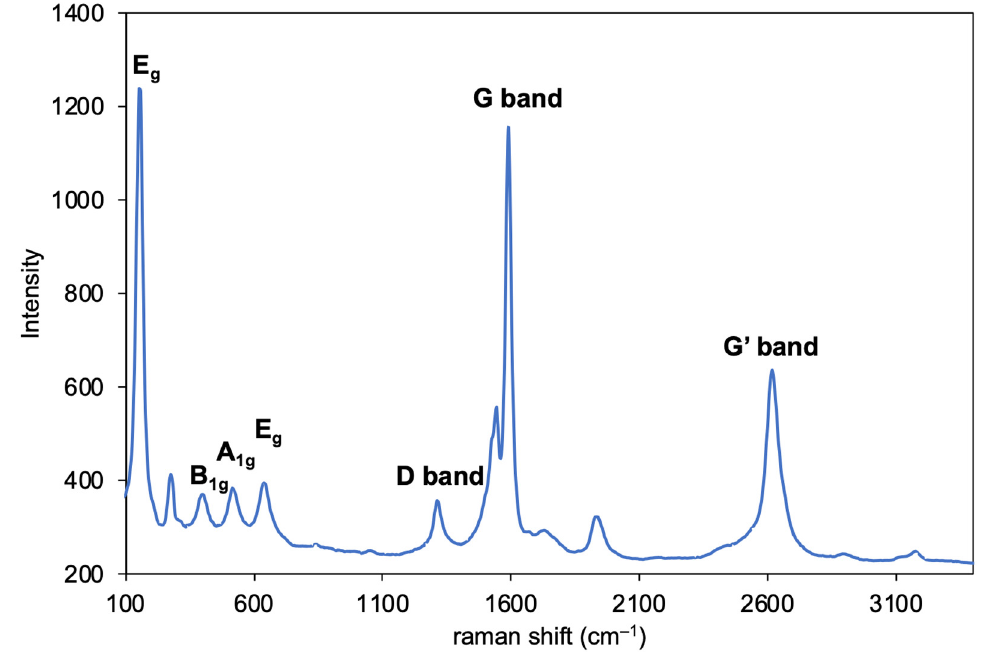
Figure 4. Raman spectrum of SWCNT/TiO 2 /Pt hybrids.